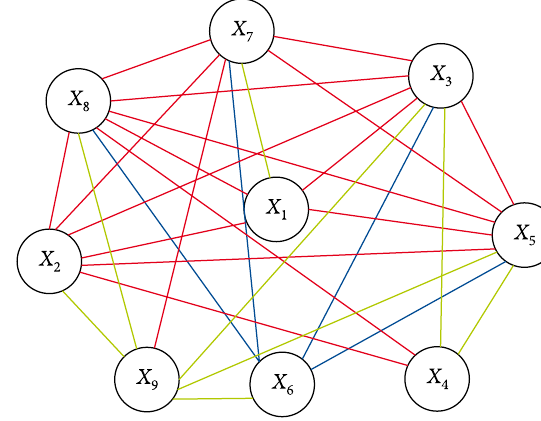
Fig. 1. Graph correlation of levelling line Jonava – Turmantas